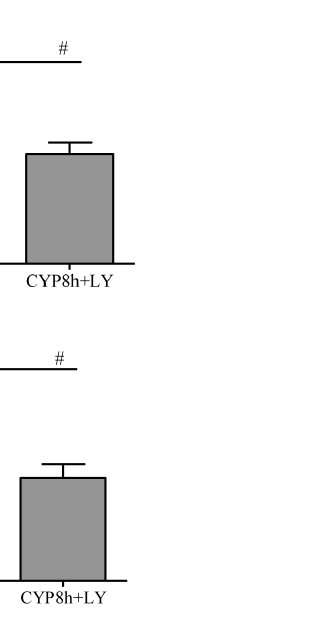
Fig. 6. PI3K inhibition decreased cystitis-induced increment of bladder weight measured in vitro and in vivo. The bladder mass was calculated by analyzing MRI data and using a formula described in the methodology (A). Postmortem measurement of the bladder weight showed an increase in cystitis animals when compared to control (B); this increment was reduced by LY294002 (LY) treatment (B). n 5 4–5. *, p , 0.05 vs vehicle control. # , p , 0.05 vs CYP